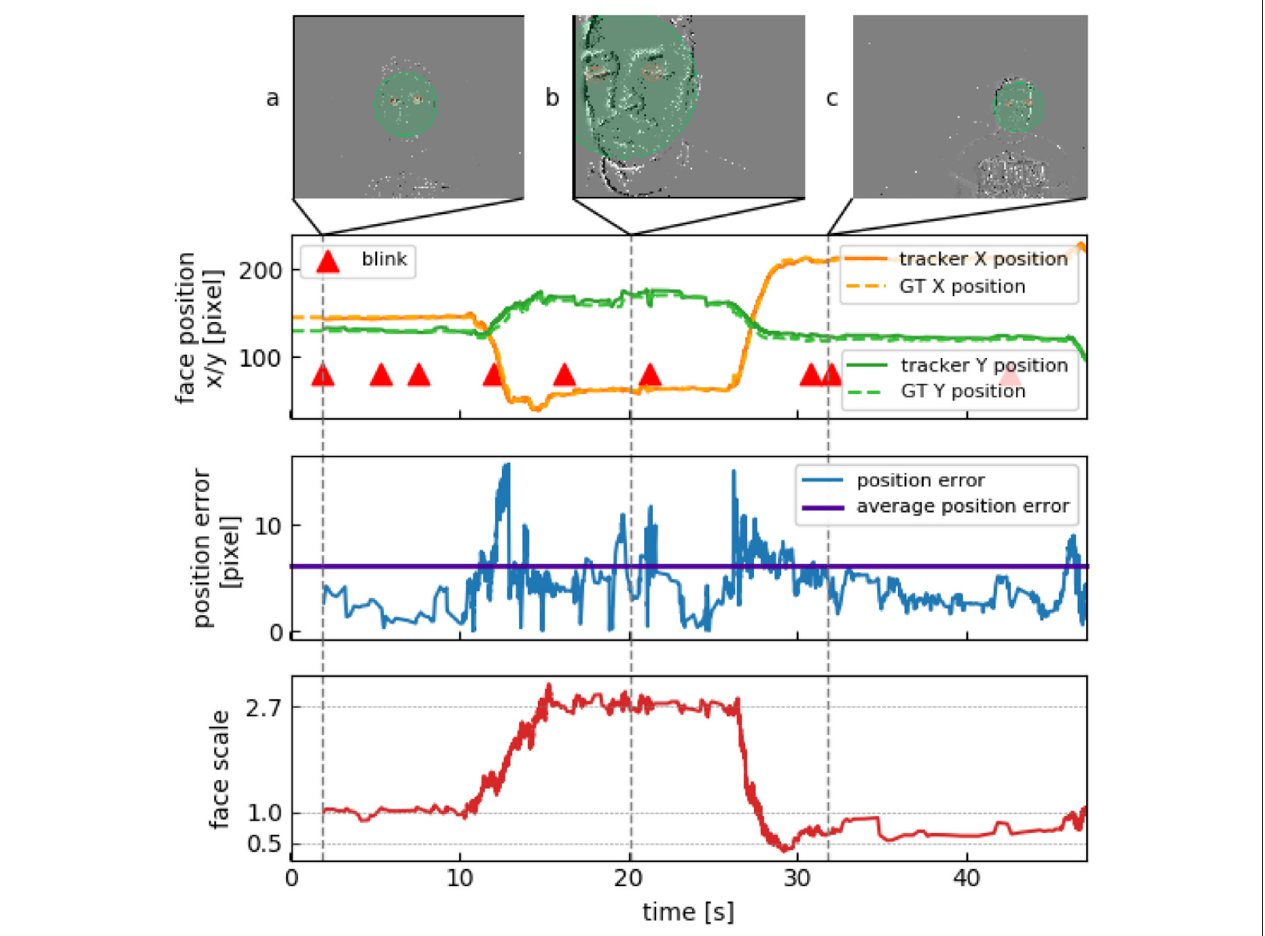
FIGURE 6 | Verifying resistance to scale. (A) First blink is detected at initial location. Scale value of 1 is assigned. (B) Subject gets within 25 cm of the camera, resulting in a three-fold scale change. (C) Subject veers away to about 150 cm, the face is now 35% smaller than in (A)